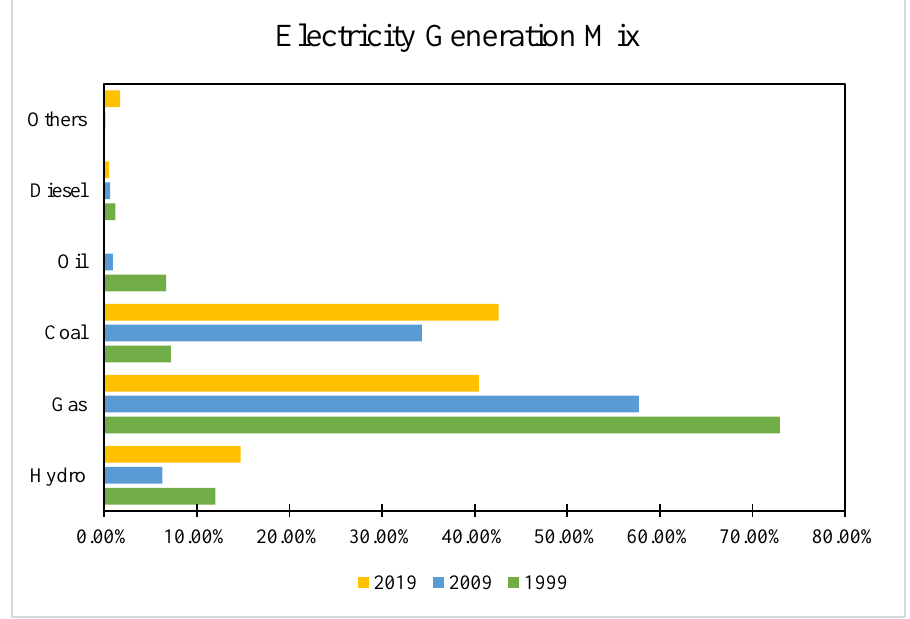
Figure 1. Electricity generation mix in the years 1999, 2009, and 2019. Source: Energy Commission [13].